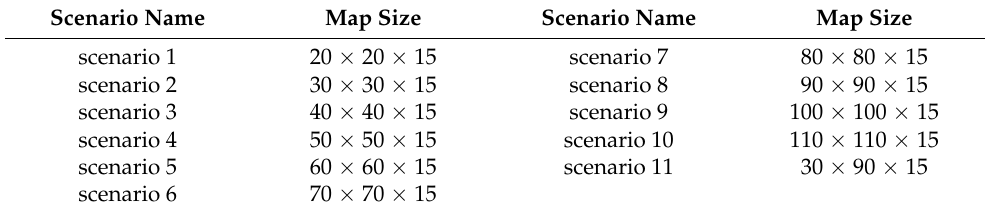
Table 1. Scenario Names of Different Map